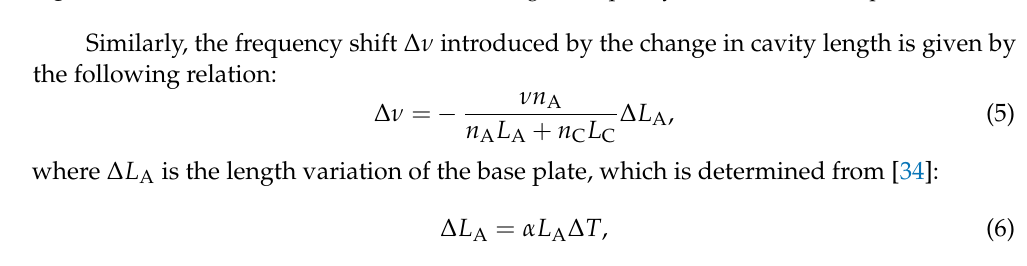
Figure 4. Measured and theoretical deviation in signal frequency as a function of air pressure shift.